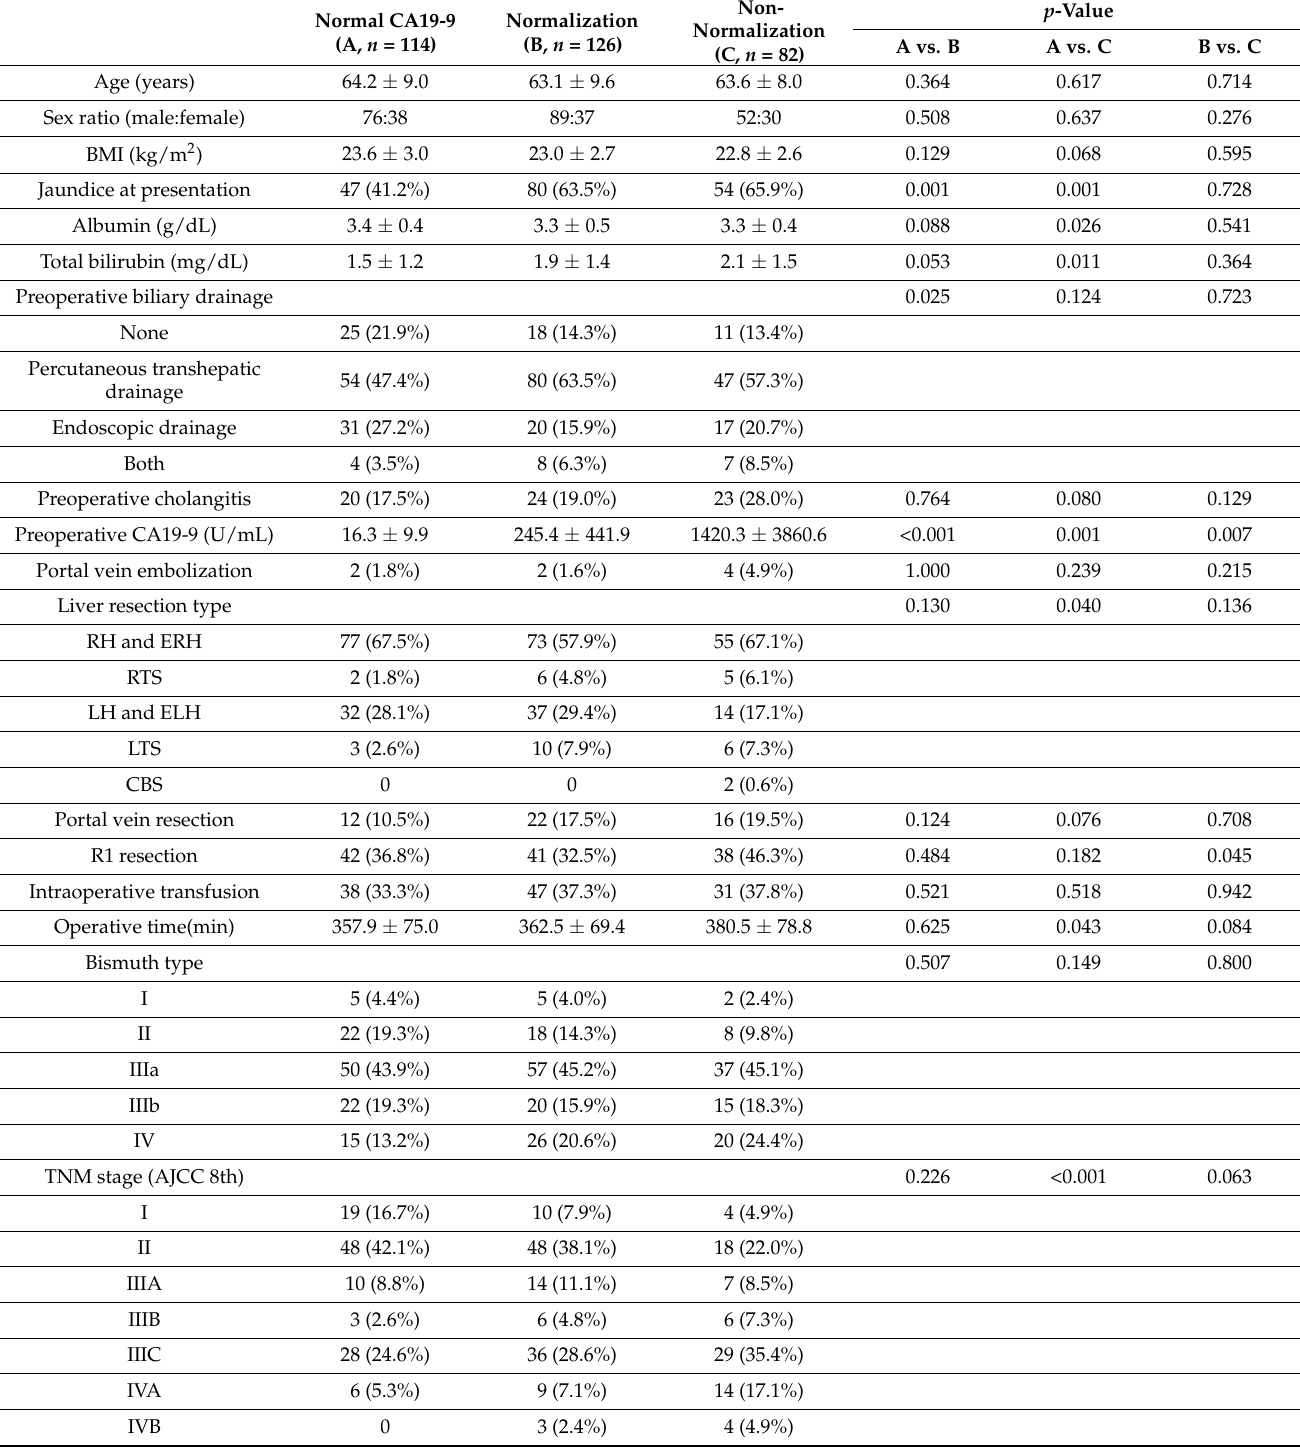
Table 1. Clinicopathological characteristics stratified by CA19-9 status of patients who underwent curative resection of perihilar cholangiocarcinoma ( n =